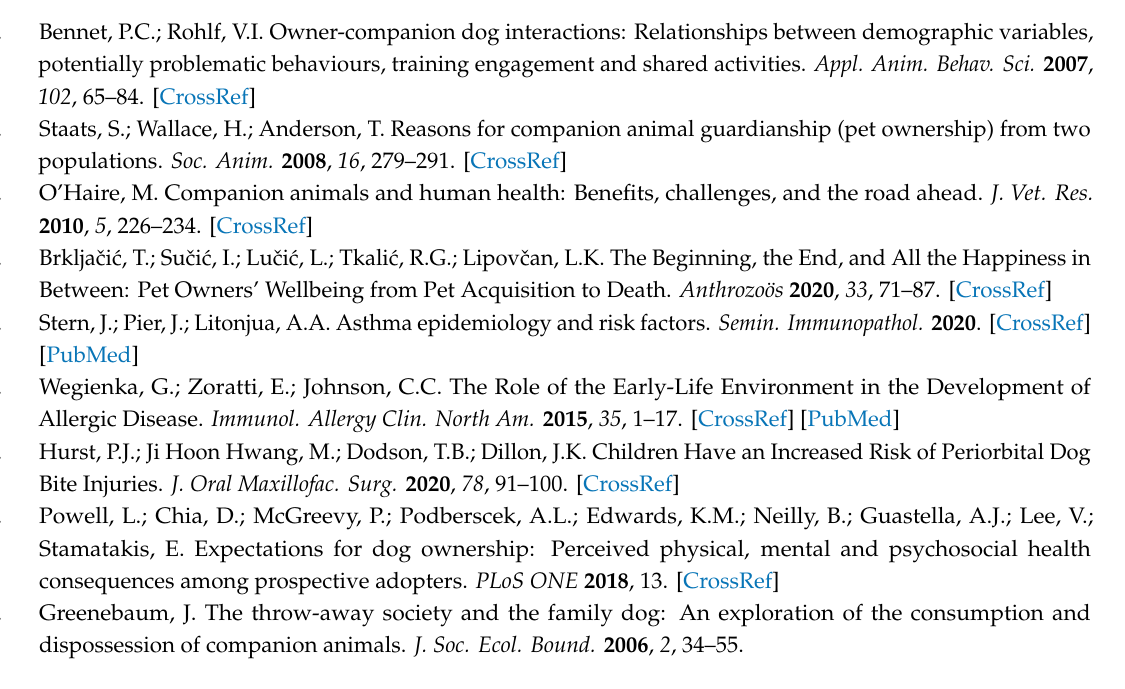
Table S1: Overview of canine behavioral problems; Table S2: Di ff erences between ownership groups for all variables by time point; Table S3: Rise and fall between time points for all variables by dog ownership group; Table S4. Descriptive elements by group and time point; Table S5. Rise and fall between time points for all variables by dog ownership group; Table S6. Di ff erences between the ownership groups for all variables by time point. Author Contributions: Conceptualization, E.M.C.B. and A.D.; Formal analysis, E.M.C.B.; Funding acquisition, A.D.; Investigation, L.M.V.; Methodology, E.M.C.B. and A.D.; Project administration, E.M.C.B. and L.M.V.; Resources, E.M.C.B.; Validation, E.M.C.B. and A.D.; Visualization, E.M.C.B.; Writing—original draft, E.M.C.B.; Writing—review & editing, E.M.C.B. and A.D. All authors have read and agreed to the published version